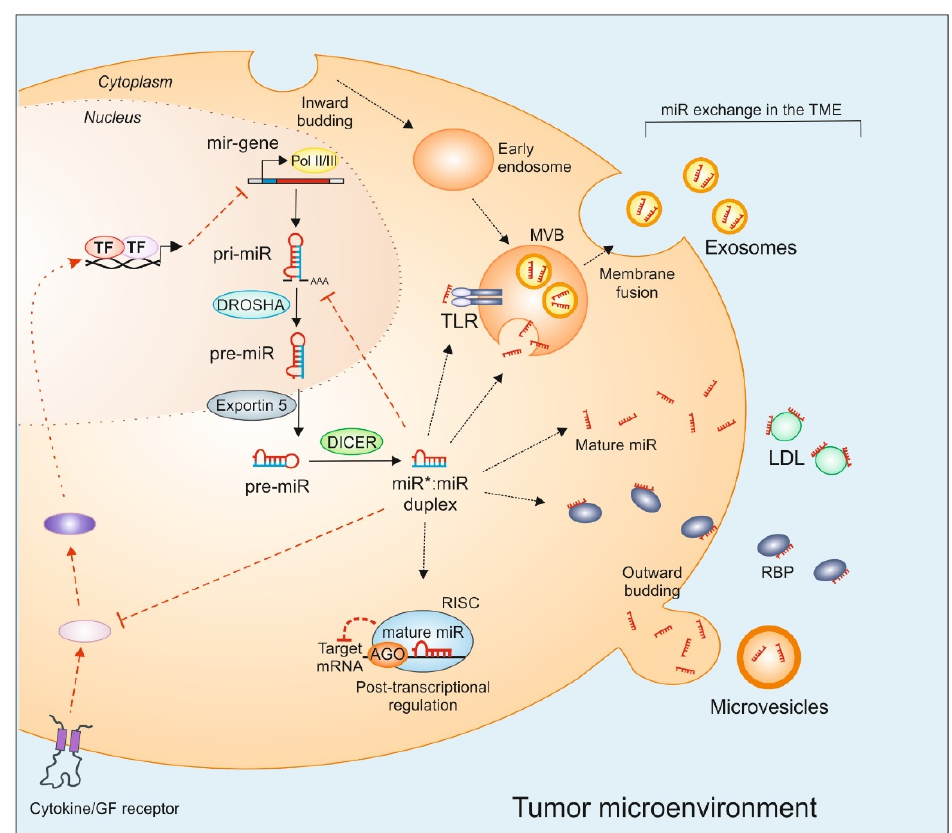
Figure 1. MiR genesis, exchange, and inter-cellular transfer. MiRs are transcribed by RNA polymerase II (Pol II) and III into primary-miRs (pri-miR), which are further processed by the Drosha complex. The resultant precursor-miR (pre-miR) is exported to the cytoplasm by exportin 5 and cleaved by Dicer to form a double-stranded miR–miR duplex. One of the strands is degraded and the mature miR strand is loaded to the Argonaute protein (AGO) complex, which together with other proteins forms the RNA-induced silencing complex (RISC). RISC complex binds, in a sequence complementary manner to the 3’-untranslated region (UTR) of mRNA targets to provoke post-transcriptional gene suppression. MiRs can be exported from donor cells into the tumor microenvironment (TME), where they can also repress target gene expression in recipient cells. Several carriers such as extracellular vesicles (exosomes, microvesicles, apoptotic bodies), RNA-binding proteins (RBP), or low-density lipoproteins (LDL) aid miR transport and exchange. Intracellularly, miRs can be loaded into multivesicular bodies (MVB), which are formed by the plasma membrane inward budding. The fusion of the MVBs with the plasma membrane provokes the release of exosomal miRs into the extraluminal space. Apart from canonical mRNA targets, inter- and intra-cellular targets of miRs include TLRs in the endosome. MiRs also interfere with cytokine and growth factor receptor signaling cascades by targeting intermediary protein expression. In turn, cell surface receptor signaling can also regulate miR biogenesis. GF: growth factor, TF: transcription factor, TLR: toll-like receptor.